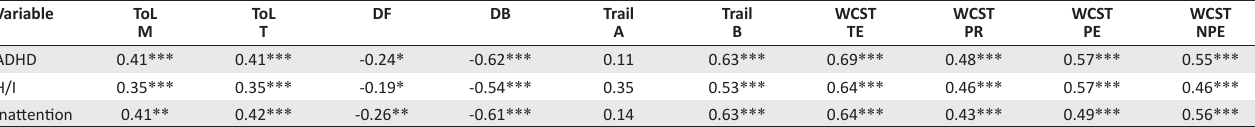
TABLE 2: Correlation between attention-deficit/hyperactivity disorder symptom domains and executive function measures. Variable ToL ToL DF DB M T